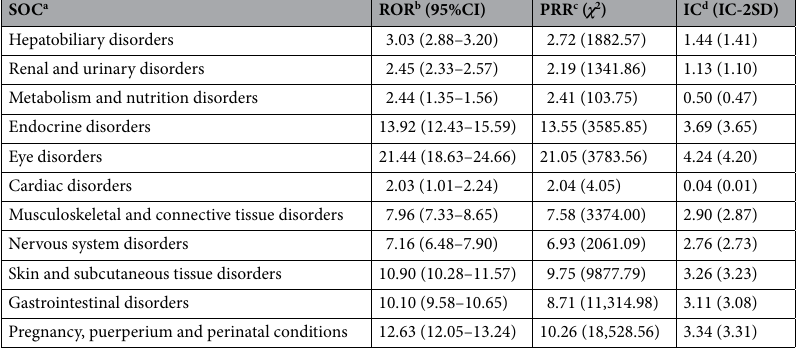
Table 2. Involved systems and signal strength for darunavir and its boosted agents based on system organ class. a SOC System organ class. b ROR reporting odds ratio. The lower limits of the 95% CI of the ROR greater than 1 indicated statistically significant RORs. c PRR proportional reporting ratio. PRR and χ 2 greater than 2 and 4 respectively indicated statistically significant PRRs. d Information component. The signal was statistically significant when IC-2SD > 0.